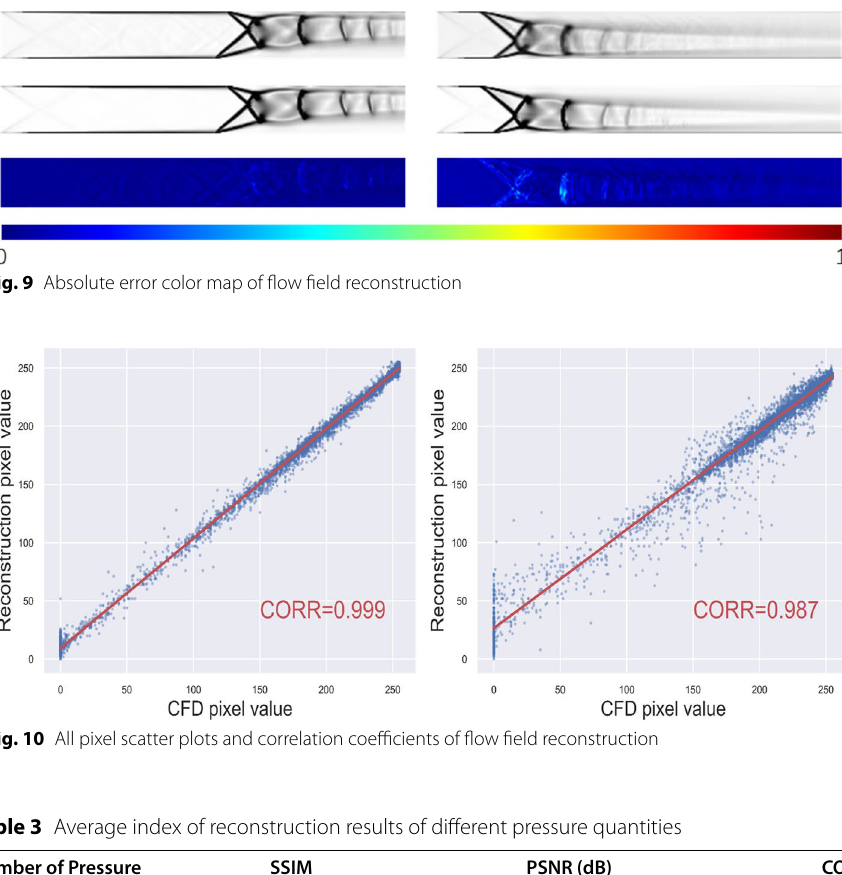
Table 3 Average index of reconstruction results of different pressure quantities Number of Pressure SSIM PSNR (dB) CORR 20 0.902 25.289 0.956 14 0.893 24.402 0.950 10 0.857 21.935